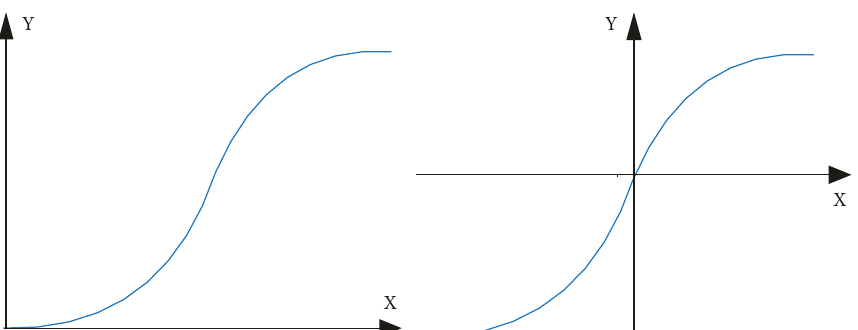
Figure 2: Sigmoid function image (left) and tanh function image (right).